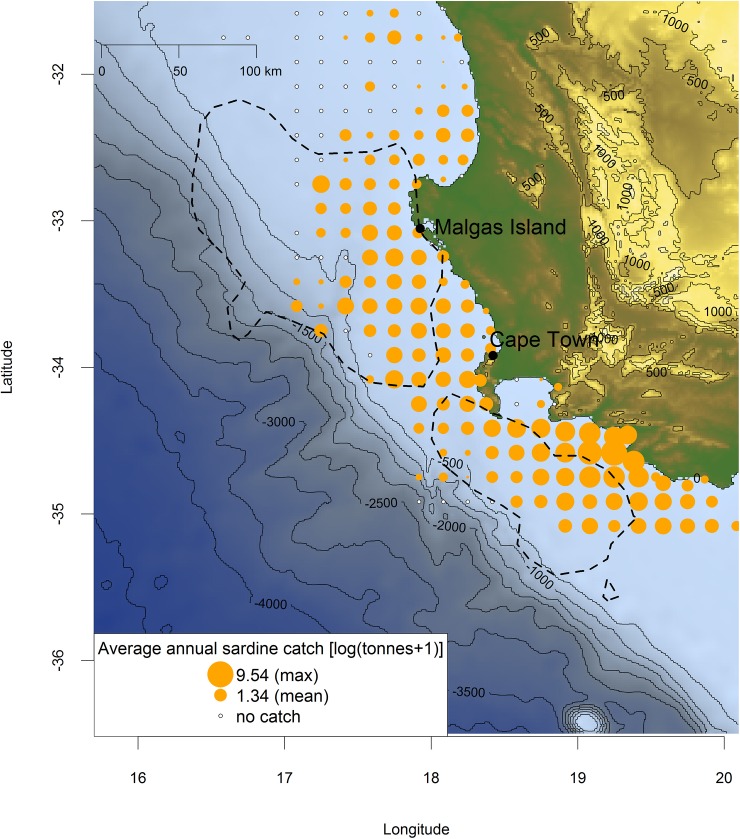
Overlap between the at-sea home-ranges of 50 GPS-tracked Cape gannets in Oct-Nov 2017 (90% kernel distributions, dotted lines) and average annual sardine catch by purse-seiners reported at a 10x10 nautical mile grid scale (log tonnes+1; orange dots) in 2008–2015.The size of orange dots increases with catch value from 0.20 to 9.54. White dots represent no catch in the fishing area. Blue shades indicate bathymetry (R package marmap).